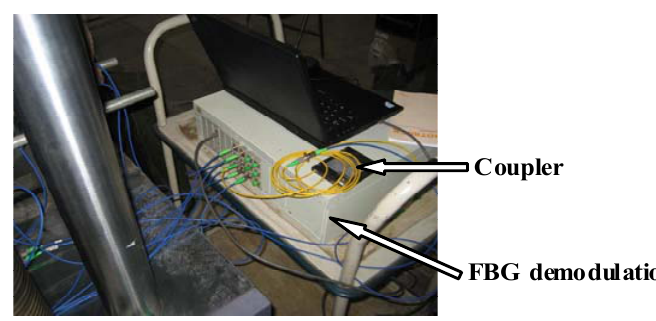
Figure 7. FBG demodulation